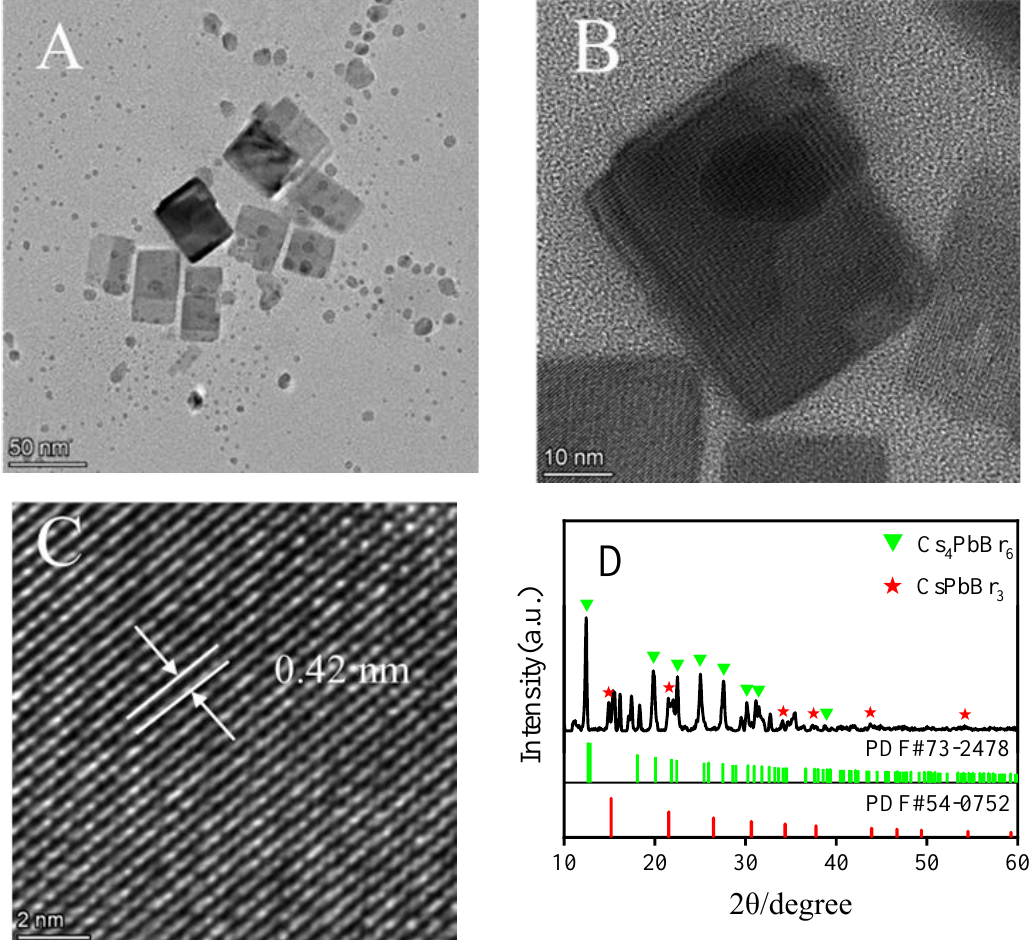
Figure 2. TEM images of CsPbBr 3 /Cs 4 PbBr 6 PNCs ( A – C ), X-ray powder diffraction patterns of CsPbBr 3 /Cs 4 PbBr 6 PNCs ( D ). Experimental conditions: synthetic precursors: CsBr (45.4 mM), PbBr 2 (45.4 mM), N-6-trifluoroacetyl-L-lysine (4.54 mM), reaction time: 2.5 h, reaction temperature: − 18 ◦ C. Synthesis of CsPbBr 3 /Cs 4 PbBr 6 PNCs: OLA (250 µ L), precursor (1.375 mL). Reaction time: 20 min, reaction temperature: 25 ◦